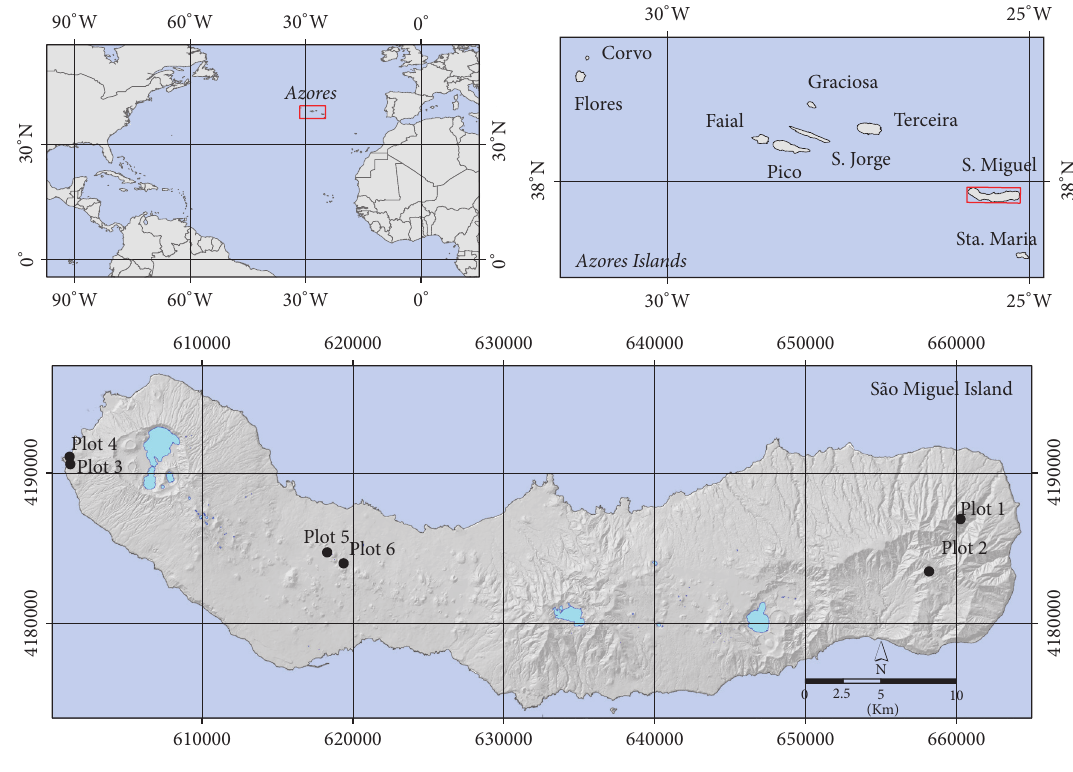
Plots dominated by P. undulatum Figure 1: Study sites location in S˜ao Miguel Island, Azores archipelago, Portugal. Plot 1, Ribeira do Guilherme, Nordeste; Plot 2, Mata dos Bispos, Povoac¸˜ao; Plot 3, Pico das Camarinhas, west slope; Plot 4, Pico das Camarinhas, Caldera; Plot 5, Pico da Furna, S˜ao Vicente Ferreira; Plot 6, Picos de Lima, Fenais da